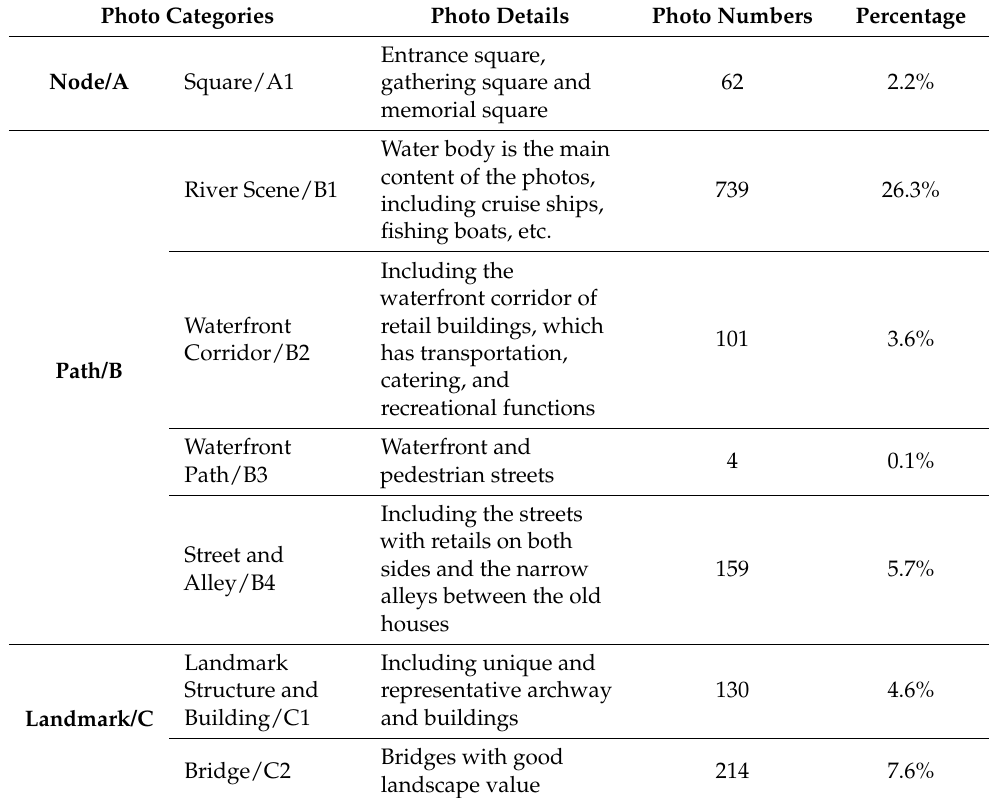
Table 3. Online travel photo content classification and analysis (source: